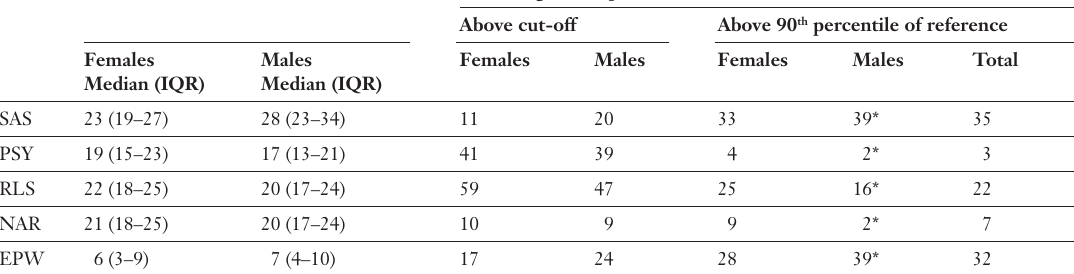
Above cut-off Above 90 th percentile of reference tion of participants (between 11.4% and 59.3%) had elevated scores in various domains of the SDQ and in the EPW, indicating sleep disorders, and excessive daytime sleepiness. The distribution of EPW scores is further illustrated in figure 1. Gen- der differences were found in all subscales of the SDQ and the EPW (p <0.01).